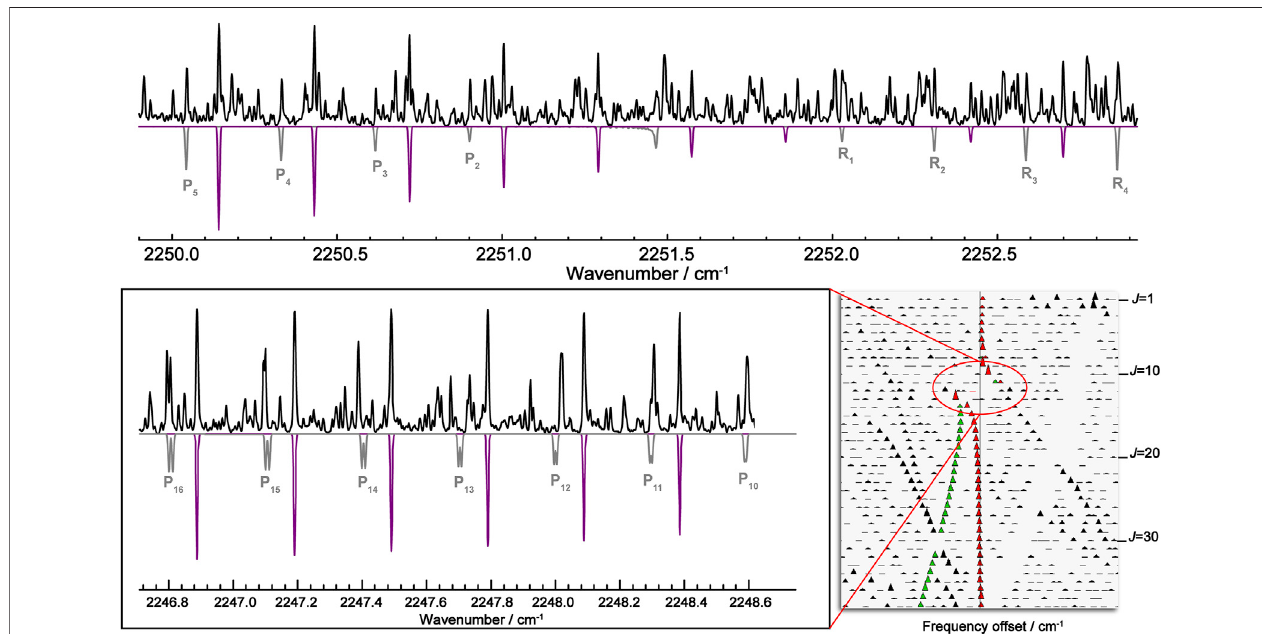
FIGURE 2 | (Top panel) : Portions of the ] 2 + ] 7 − ] 7 band of DC 3 N. Recording conditions: T (cid:2) 298 K, p (cid:2) 32 Pa, L opt (cid:2) 8 m, 200 scans, unapodized resolution 0.004 cm − 1 . (Bottom panel) : Detail of the spectrum (left) together with its Loomis-Wood plot (right) where the strongest perturbations are visible. Additional lines present in the spectra arise from other hot-bands, which will be targeted in future studies.